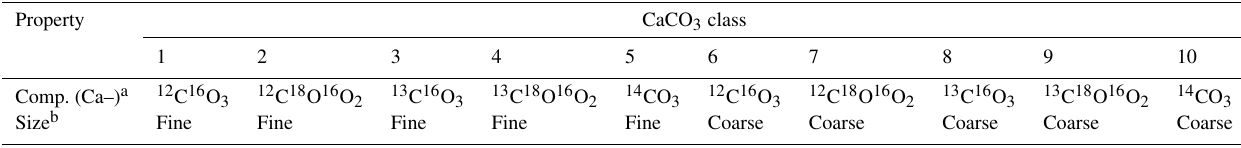
Table 5. Properties of CaCO 3 classes for simulations in Sect. 3.3. Property CaCO 3